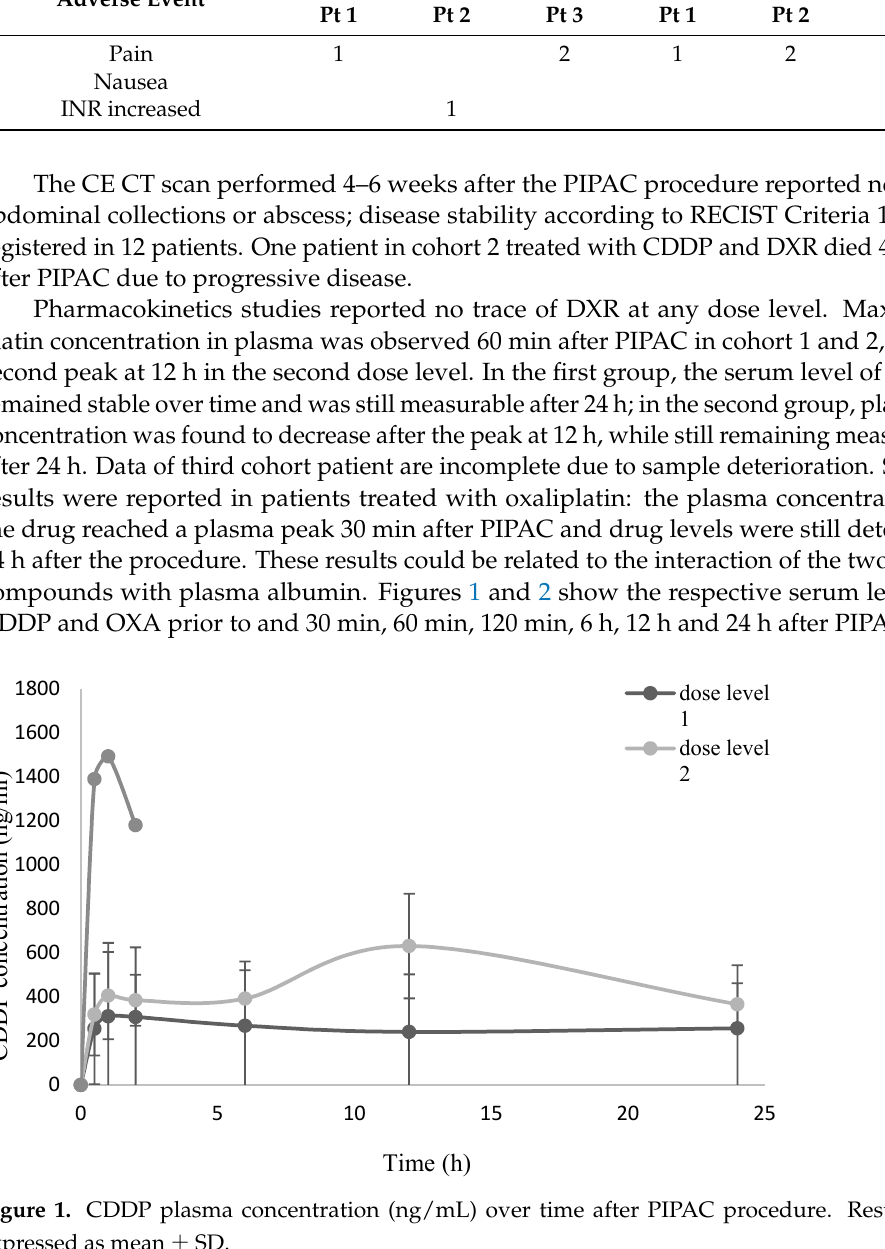
Figure 2. OXA plasma concentration (ng/mL) over time after PIPAC procedure. Results are expressed as mean ± SD. 4. Discussion Peritoneal carcinomatosis is a common and challenging evolution of several tumors, including gastro-intestinal, ovarian, hepatobiliary and pancreatic cancer; moreover, it could be the clinical presentation of primitive peritoneal neoplasms such as diffuse peri- toneal mesothelioma and primary peritoneal carcinomas. The therapy of peritoneal carci- nomatosis is largely palliative, based on systemic chemotherapy: its low efficacy is due to the poor peritoneal drug distribution and penetration into cancer nodules [29,30]. A sig- nificant pharmacological advantage is given by intraperitoneal chemotherapy, burdened anyhow by a large number of unfinished treatments for complications related to the in- traperitoneal catheter. In this scenario, the PIPAC procedure added the advantage of pres- surized aerosolization and drug micronization, achieving better distribution and penetra- tion into peritoneal tissues with a negligible systemic toxicity [6,10]. Evidence from retrospective and prospective studies demonstrated that the arbitrar- ily established doses applied as PIPAC of oxaliplatin 92 mg/m 2 and doxorubicin 1.5 mg/m 2 associated with cisplatin 7.5 mg/m 2 are safe, well tolerated and efficacious [31]. To our knowledge there is only one published phase I trial evaluating the use of cis- platin and doxorubicin applied as pressurized intraperitoneal aerosol in patients with PC of ovarian origin. The dose escalation design was based on very low dose increases be- tween steps: the maximum tolerable dose was not reached, and the study was stopped